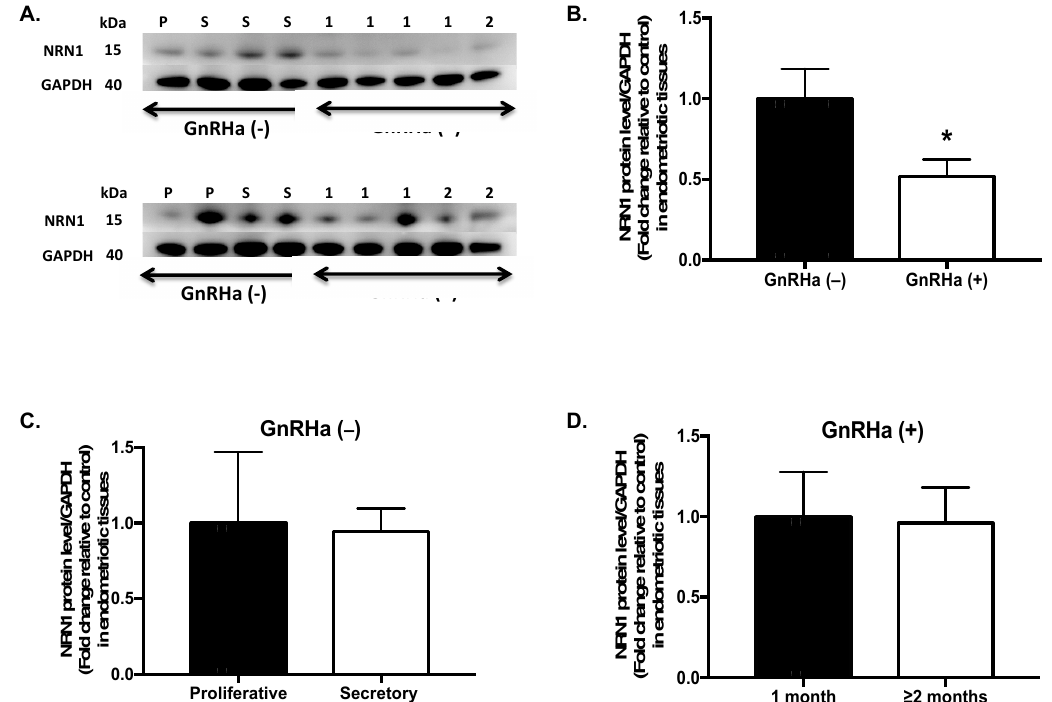
Figure 2. Expression of the NRN1 protein in endometriotic tissues. ( A ) Western blot images of NRN1 protein expression in patients treated with a gonadotrophin-releasing hormone agonist (GnRHa ( + ), n = 10) and in those not treated with a GnRHa (GnRHa ( − ), n = 8). P, proliferative; S, secretory; 1, patients treated for 1 month; 2, patients treated for 2 months. Glyceraldehyde 3-phosphate dehydrogenase (GAPDH) was the loading control. ( B ) The intensity of the NRN1 and GAPDH bands was quantified and is shown as a bar plot. * p = 0.0155. ( C ) NRN1 protein level in the GnRHa ( − ) group in the proliferative ( n = 3) and secretory ( n = 5) phases of the menstrual cycle. ( D ) The NRN1 protein level in the GnRHa ( + ) group in patients who were treated for 1 month ( n = 7) and in those who were treated for ≥ 2 months ( n = 3). The data are expressed as the mean ± standard error of the mean. n , number of patients. The non-parametric Mann–Whitney U test was used for statistical analysis. Significance was set at p < 0.05.